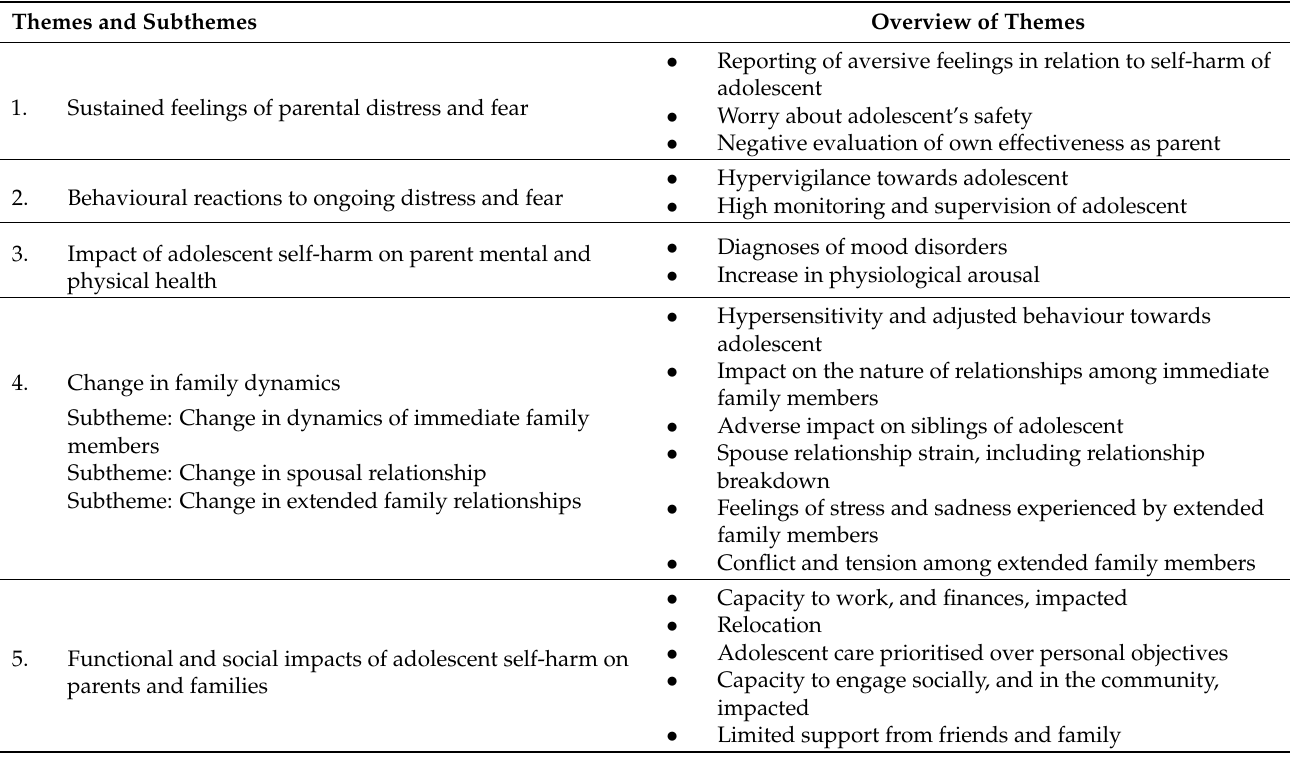
Table 3. The impact of adolescent self-harm on